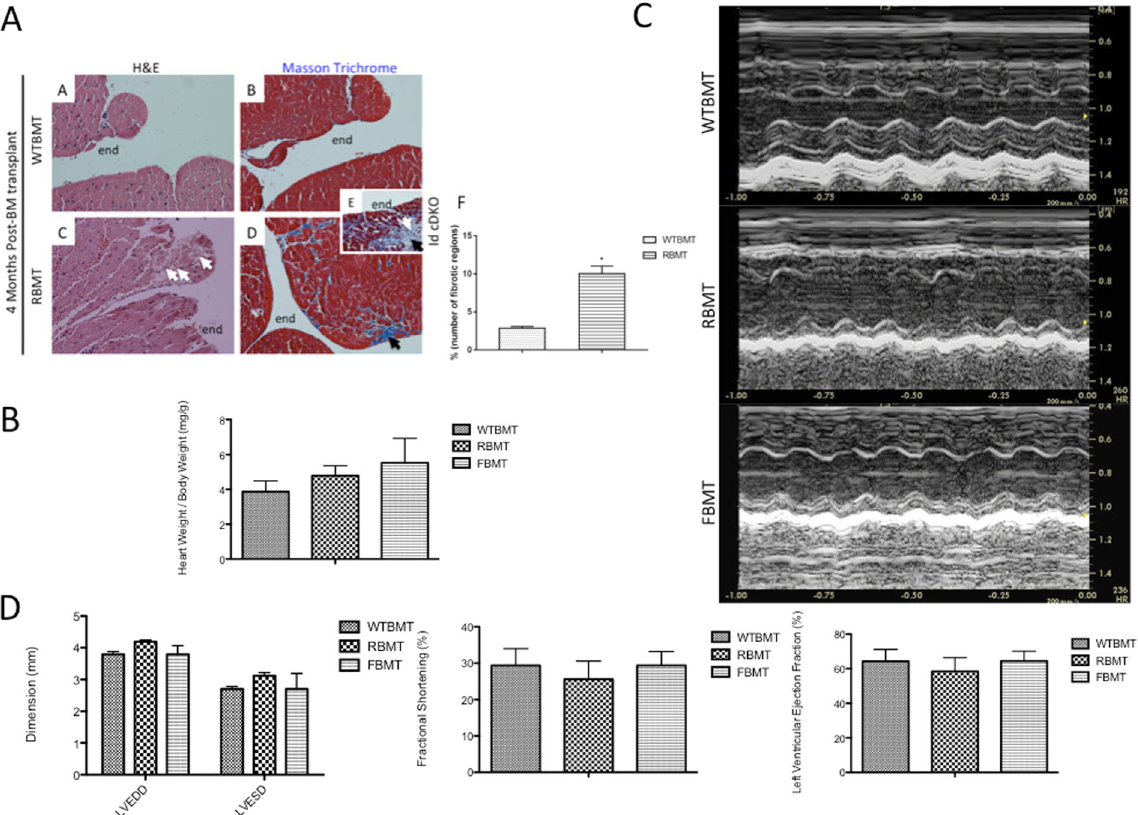
Figure 4. Transfer of Id null bone marrow cells into WT recipients (R-BMT) leads to development of endomyocardial fibrosis. ( A ) Representative H&E stains and Masson Trichrome stains of WTBMT (Images A&B) and RBMT (Images C&D) hearts of recipients 4 months post transplantation. Inset E shows typical Id cDKO cardiac pathology for comparison. White arrows show areas of endocardial disruption and mononuclear invasion. Black arrows show regions of fibrosis. (Magnification: 200x). Bar graph in F shows quantitation of % of number of fibrotic regions (number of regions containing fibrosis)/(number of regions containing cardiac muscle) × 100. WTBMT: n = 2, 10 sections and RBMT: n = 4, 15 sections. * p < 0.05. Data presented as Mean ± SEM. ( B ) Quantitation of heart weight/body weight ratio expressed as mg/g of body weight of WTBMT (n = 11), RBMT (n = 7) and FBMT (n = 5). ( C ) Representative echocardiographs of 6 month-old WTBMT, RBMT and FBMT mice. ( D ) Cardiac function parameters (Dimension, Fractional Shortening and Left Ventricular Ejection Fraction) of 6 month-old WTBMT (n = 14), RBMT (n = 9) and FBMT (n = 5) mice. LVEDD = left ventricular end diastolic diameter, LVESD = left ventricular end systolic diameter. n = number of mice. Data presented as Mean ±